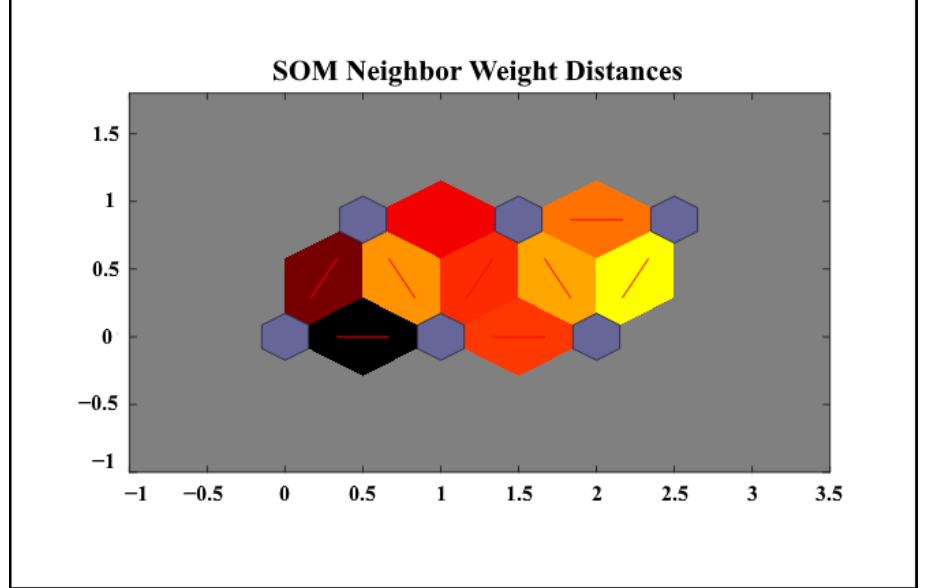
Figure 3. Graph of distances between neighboring neurons in the SOM network. Note: Colored areas represent individual clusters.